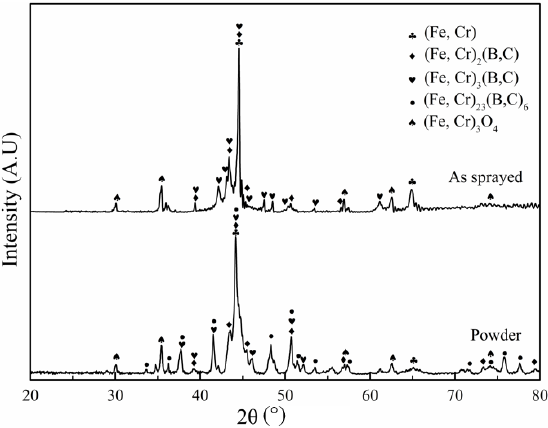
Figure 4. XRD patterns of the Fe-Cr-B-C powder and coating.